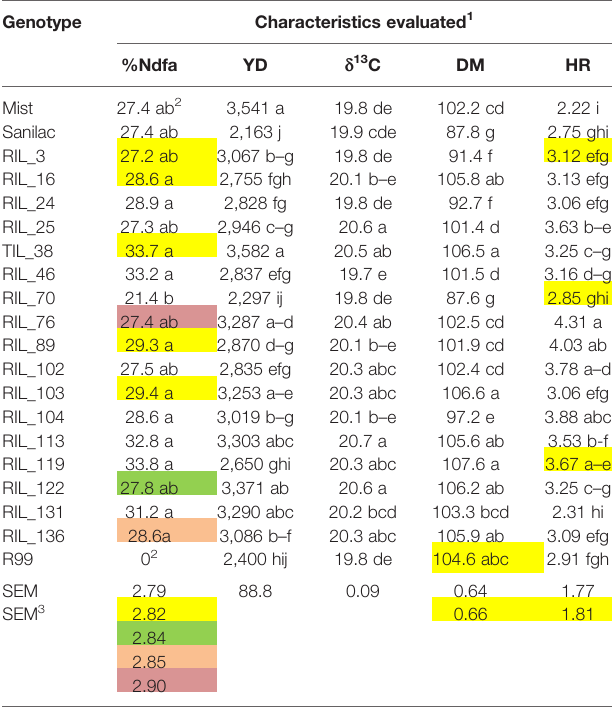
TABLE 3 | Performance of 20 common bean genotypes evaluated at the Elora research station, ON in 2016 pilot study. Genotype